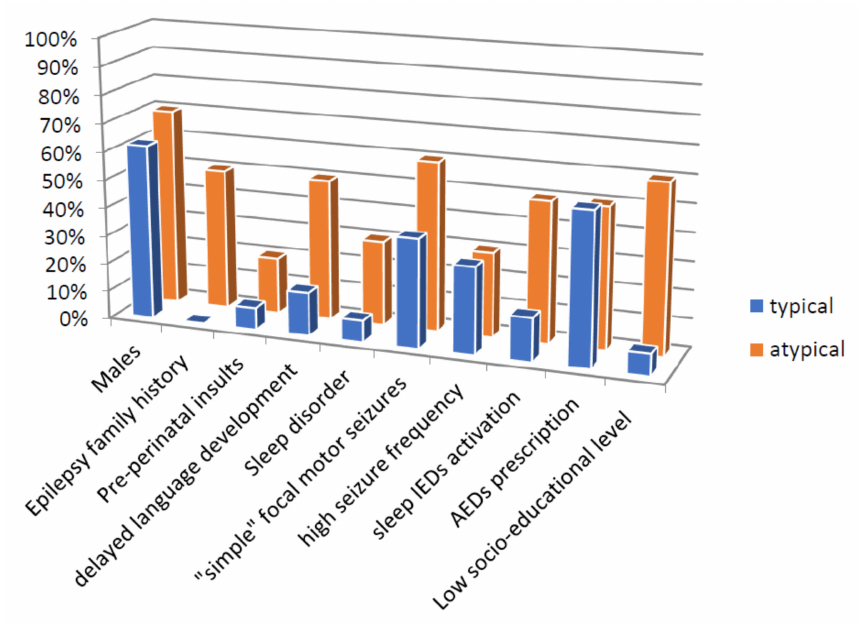
Figure 1. Socio-demographical and electro-clinical di ff erences in the two groups of neuropsychological